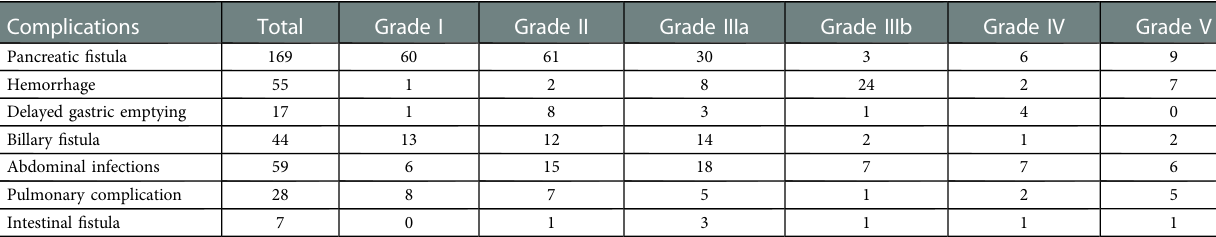
TABLE 2 Clavien – Dindo classi fi cation of postoperative complications.